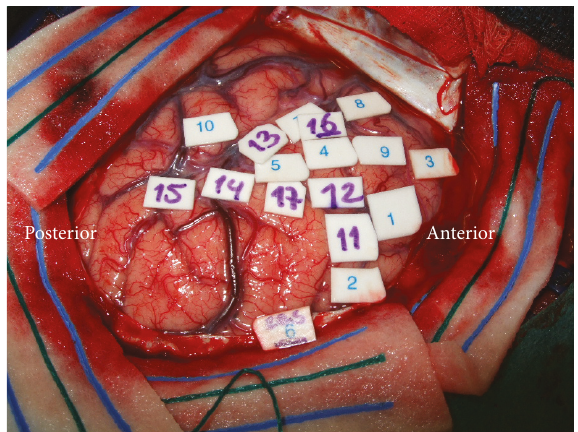
Figure 3: Intraoperative mapping P3. Cortical positive sites : speech